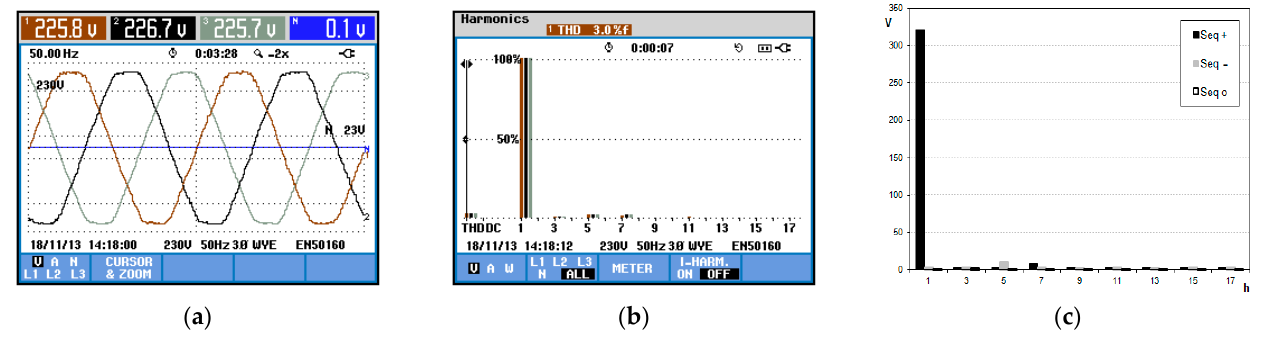
Figure 40. Case 5 - ZSS and three-wire ShAPF operating with unbalanced loads: ( a ) three-phase voltages; ( b ) harmonic spectrum of the voltages; ( c ) harmonic spectrum of the voltage sequence components (maximum values).